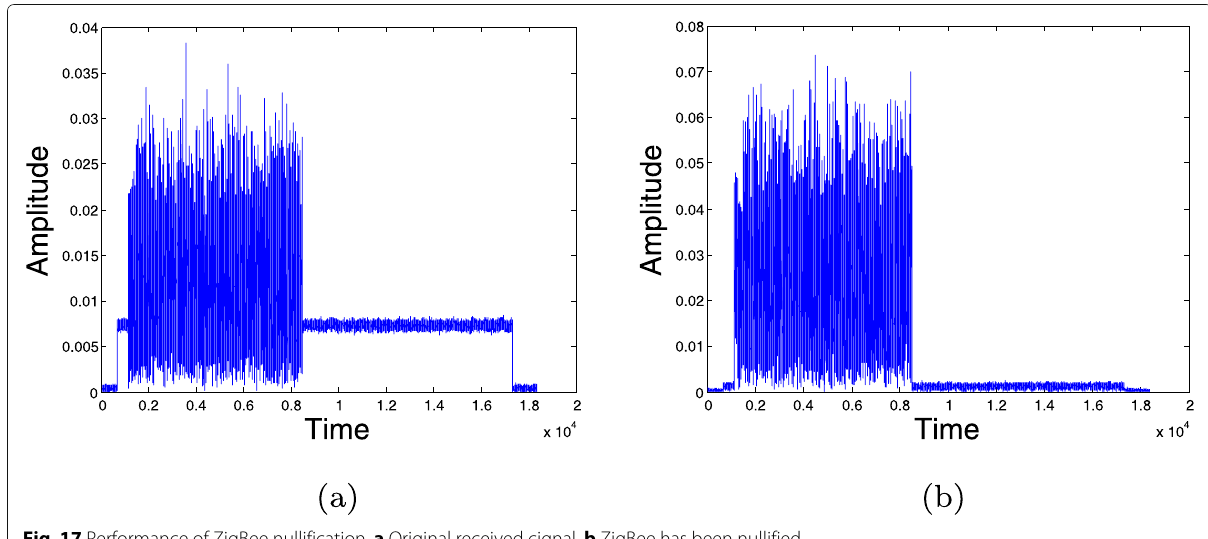
Fig. 17 Performance of ZigBee nullification. a Original received cignal. b ZigBee has been nullified